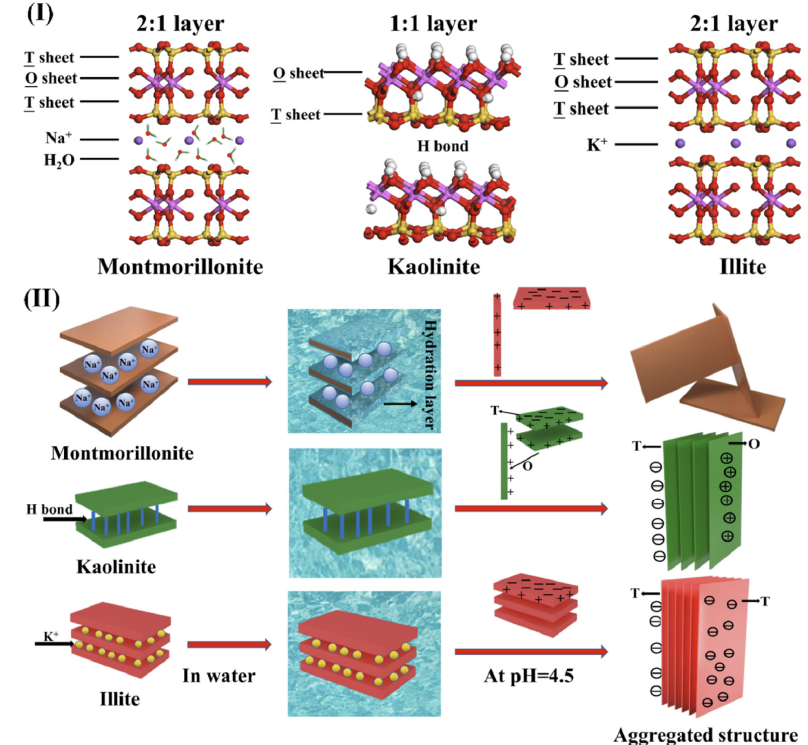
Figure 14. Schematic of the structures of clay minerals ( I ) and schematic illustration of different behaviors derived from various structures of clay minerals ( II ). Reprinted with permission from Ref. [116]. Copyright 2020, copyright the American Chemical Society. More details on Copyright